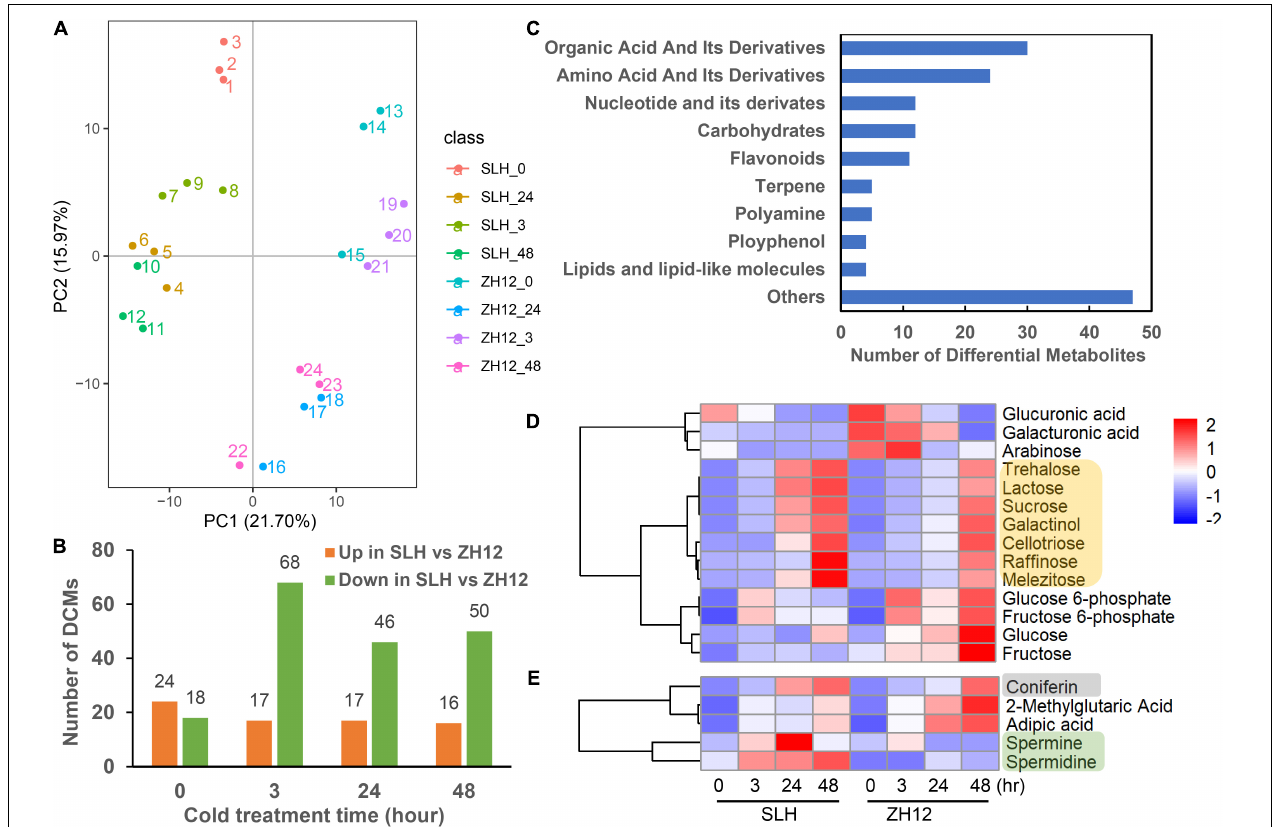
FIGURE 2 | Metabolite profiling of two peanut varieties exposed to cold stress. (A) Principle component analysis (PCA) of metabolome data derived from SLH and ZH12 during four time points under cold stress (0, 3, 24, 48 h, with three biological replicates per point). (B) The differentially changed metabolites (DCMs) between the SLH and ZH12 under cold stress. The DCMs were screened by the criteria of | log 2 (fold change) | > 1 and P -value < 0.05. (C) Classification of 145 DCMs between the two cultivars. (D,E) The accumulation pattern of carbohydrates (indicated by yellow), polyamines (marked by green), and phenols (gray) under cold stress in SLH and ZH12. The relative contents of metabolites (represented by the LC-MS/MS peak area) in different samples were used for z-scale normalization in the heatmap. The red color indicated relative high content of substances, while blue was low.